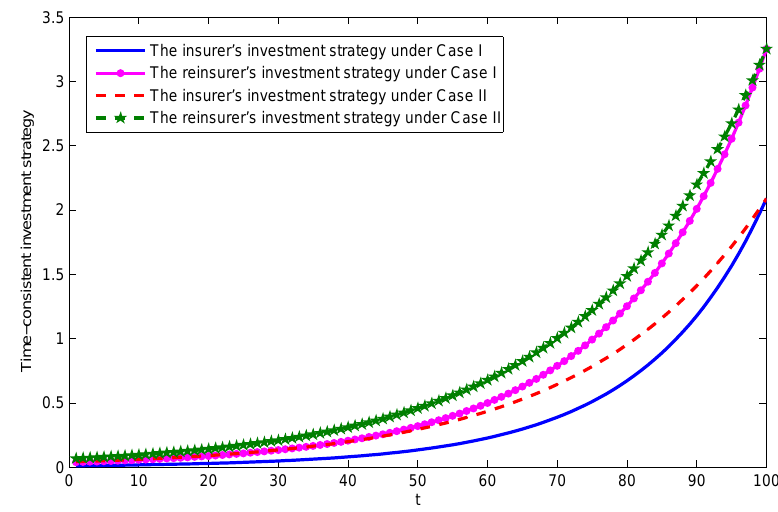
Figure 1. Time-consistent investment strategies for the insurer and the reinsurer ( T = 100).